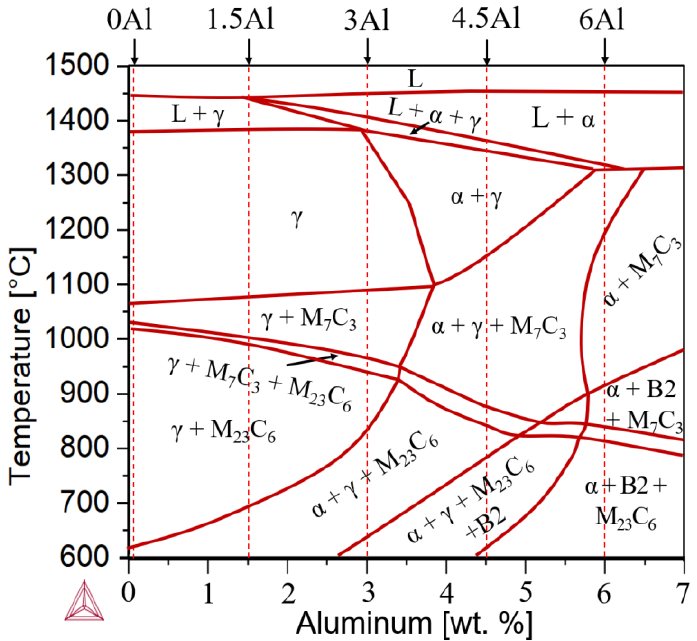
Figure 2. Pseudo-binary phase diagram of Fe-12Cr-9Ni-3Mn-0.3C as a function of Al content, calcu- lated using Thermo-Calc. The positions of alloys are marked by vertical dashed lines. Table 2. Solidification modes based on thermodynamic equilibrium calculations by Thermo-Calc and DSC measurements. A and FA stand for austenitic and ferritic-austenitic solidification modes, respectively. In the latter case, the solidification begins with the formation of primary ferrite and continues with the formation of austenite.